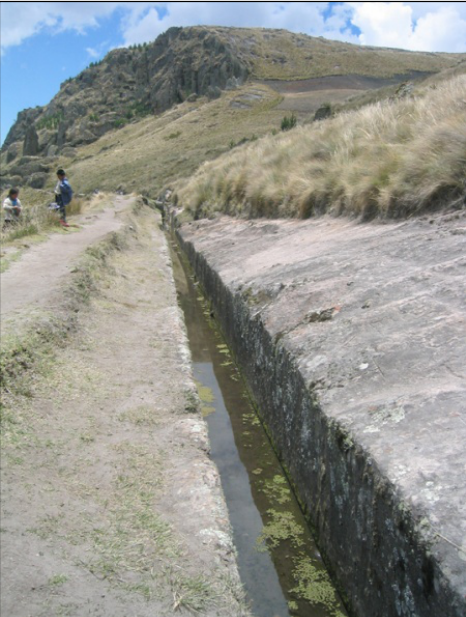
Figure 3. Cumbe Mayo aqueduct (image in the public